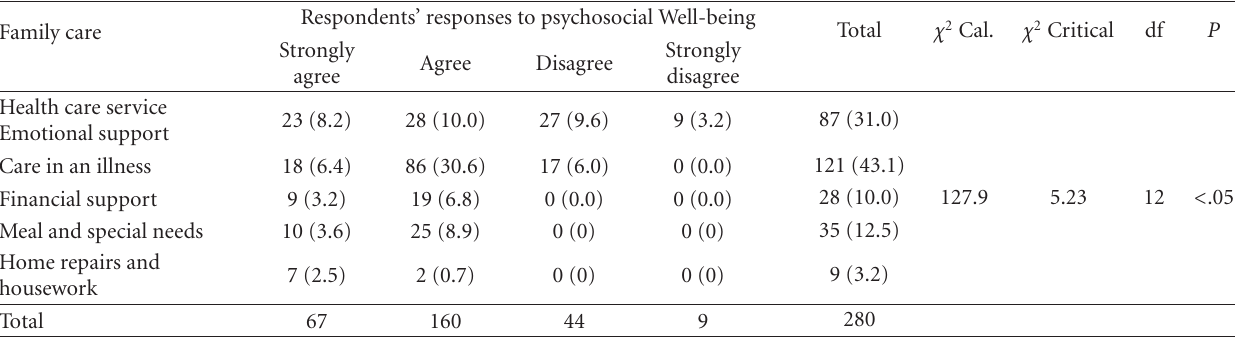
Table 1: Cross-tabulation and chi-square analysis of family care and psychosocial well-being elderly. Family